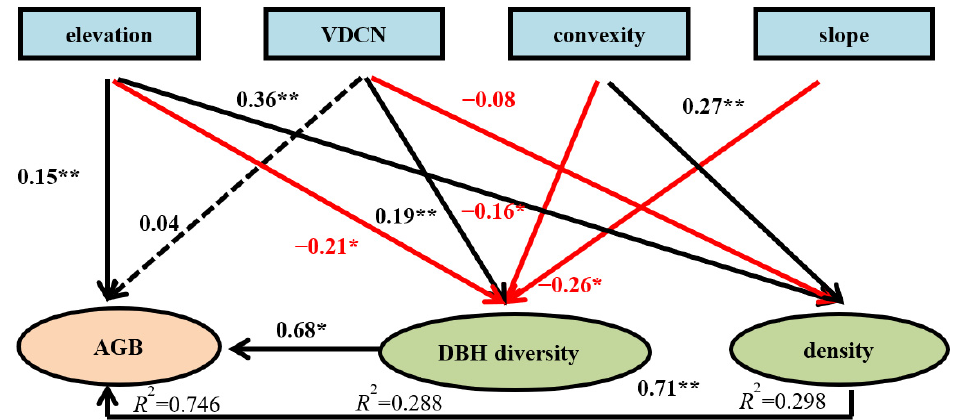
Figure 5. The structural equation model (SEM) of AGB, topographical, and structural variables. The standardized estimated coe ffi cient (beta) and significance (* < 0.05, ** < 0.001) are given for the SEM. Red arrows denote negative correlations. Black arrows denote positive correlations. The dotted arrow shows nonsignificant e ff ects. The solid arrows show significant e ff ects. Numbers close to variables ( R 2 ) indicate the variance explained by the model.